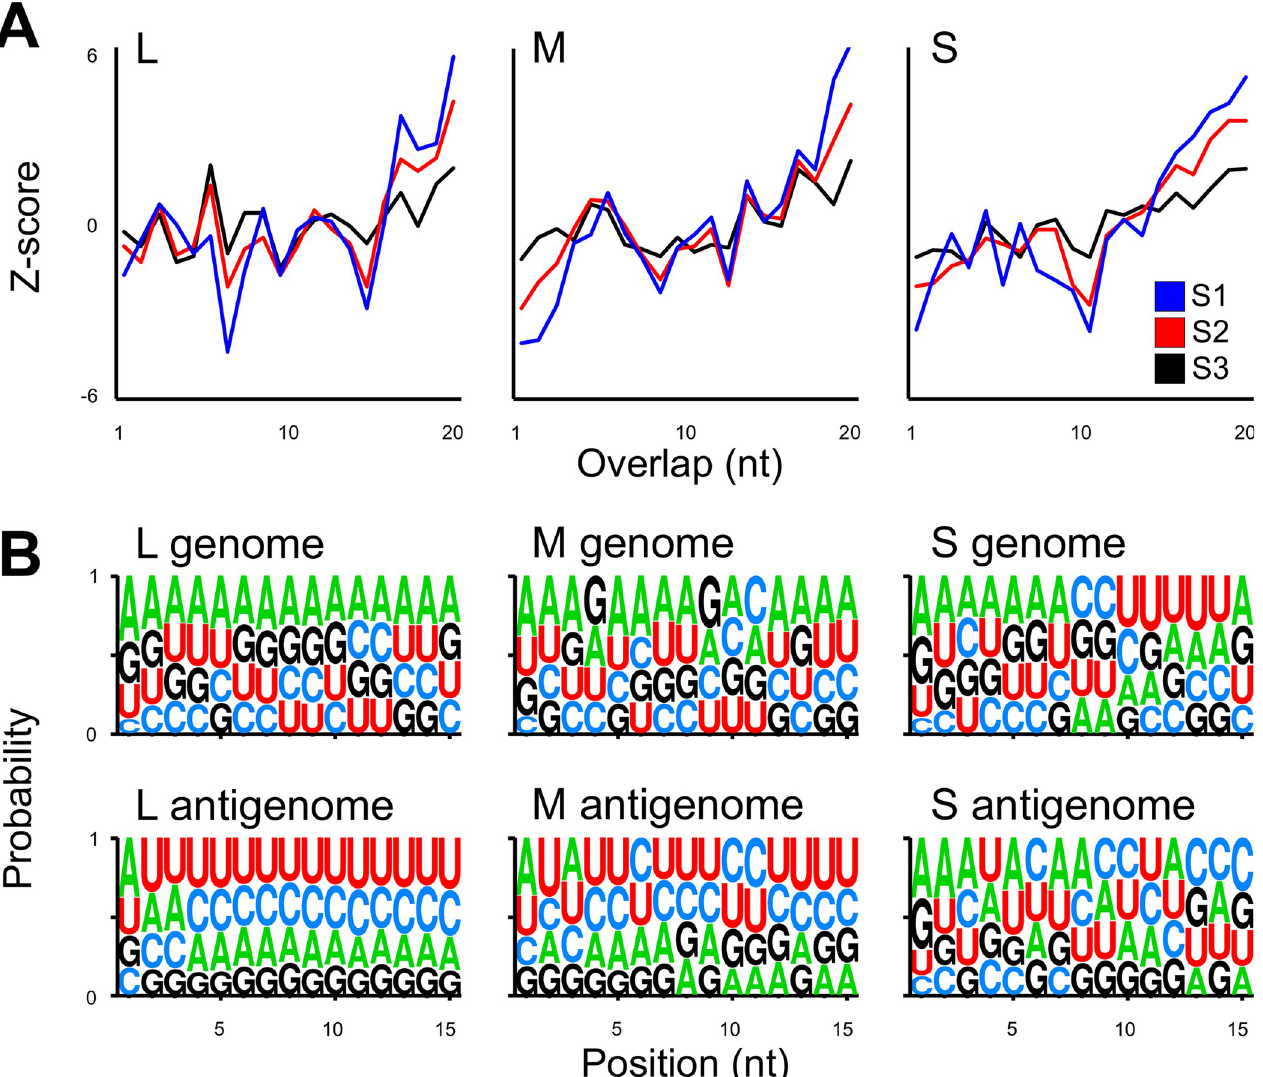
Fig 11. Z-scores and sequence logo analysis of 24–29 nt small RNAs produced in rTOSV-infected PP9ad cells. (A) Z-score of combined genomic and antigenomic 24–29 nt small RNAs mapping to rTOSV L, M or S segments. Expected for vpiRNAs would be a prominent peak at the 10 nt overlap position if these were present. Individual replicates are indicated by colour, S1-3. (B) Sequence logo analysis, as determined by seqLogo of nucleotide predominance of the first 15 nt of each of 24–29 nt small RNAs (mapping to L, M or S genome or antigenome segments, as indicated) of all replicates